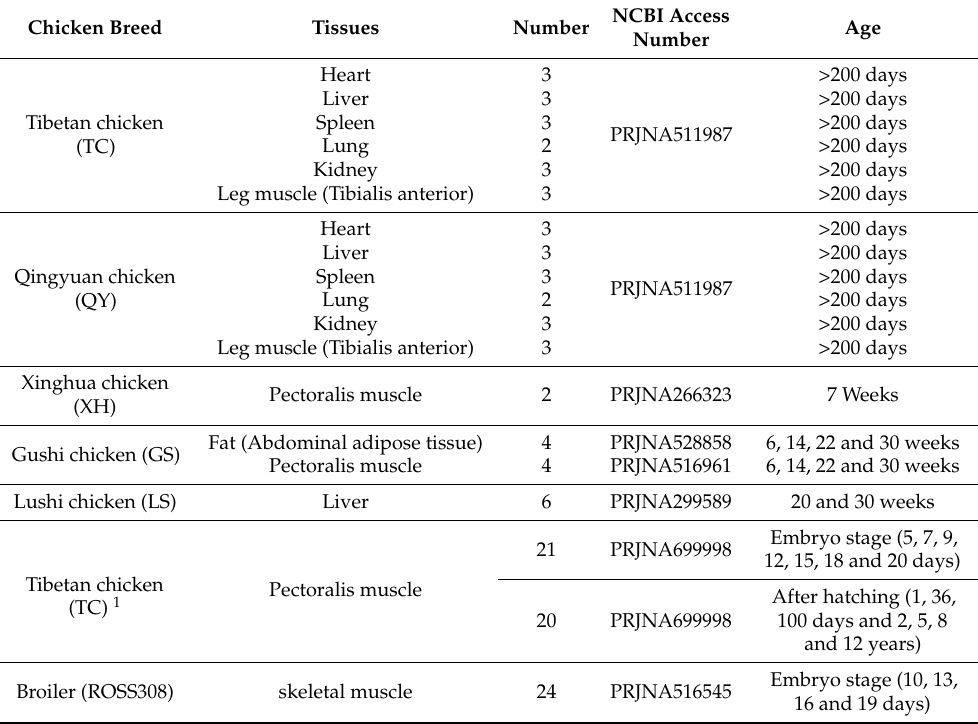
Table 1. The summaries of sample